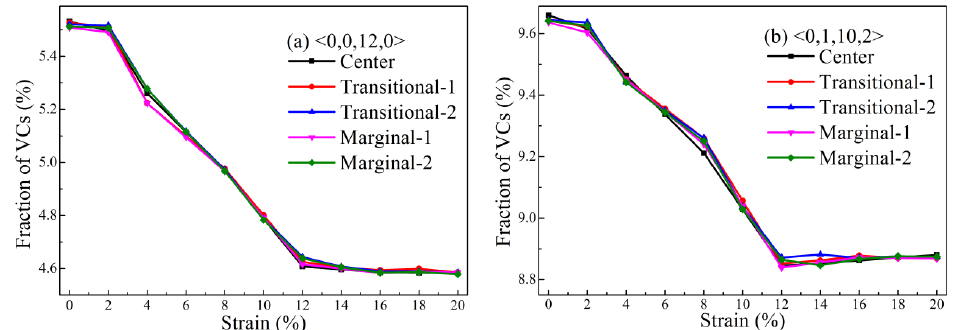
Figure 3. Distribution of some major VCs such as ( a ) <0,0,12,0> and ( b ) <0,1,10,2> in the center, transitional, and marginal regions of the structural model under